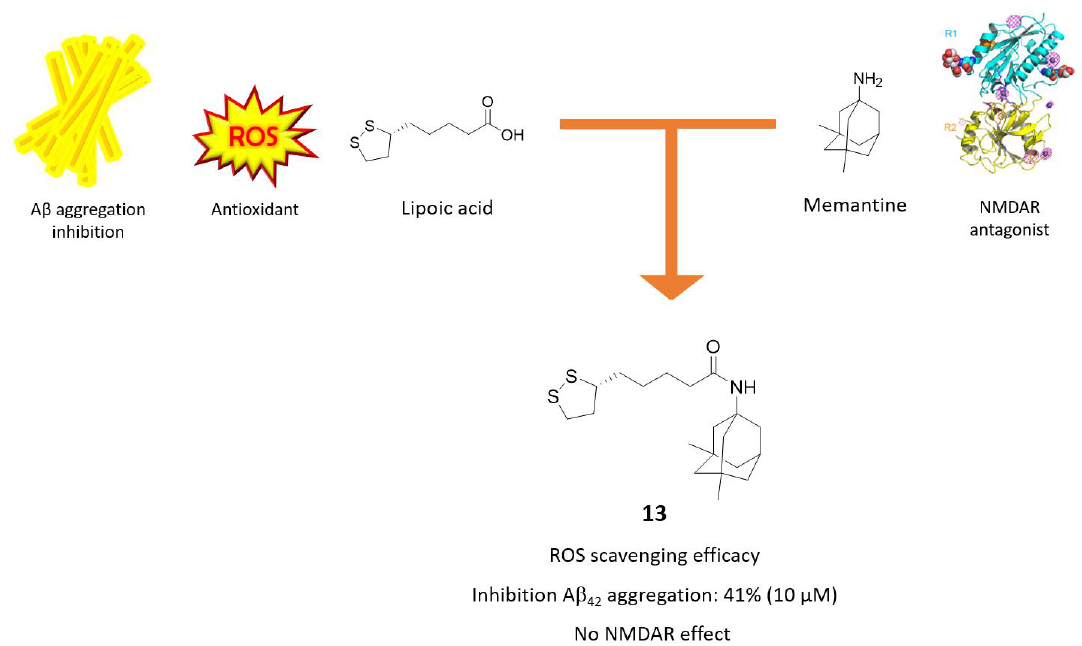
Figure 8. Drug design and biological activities of lipoic acid-memantine hybrid 13 .